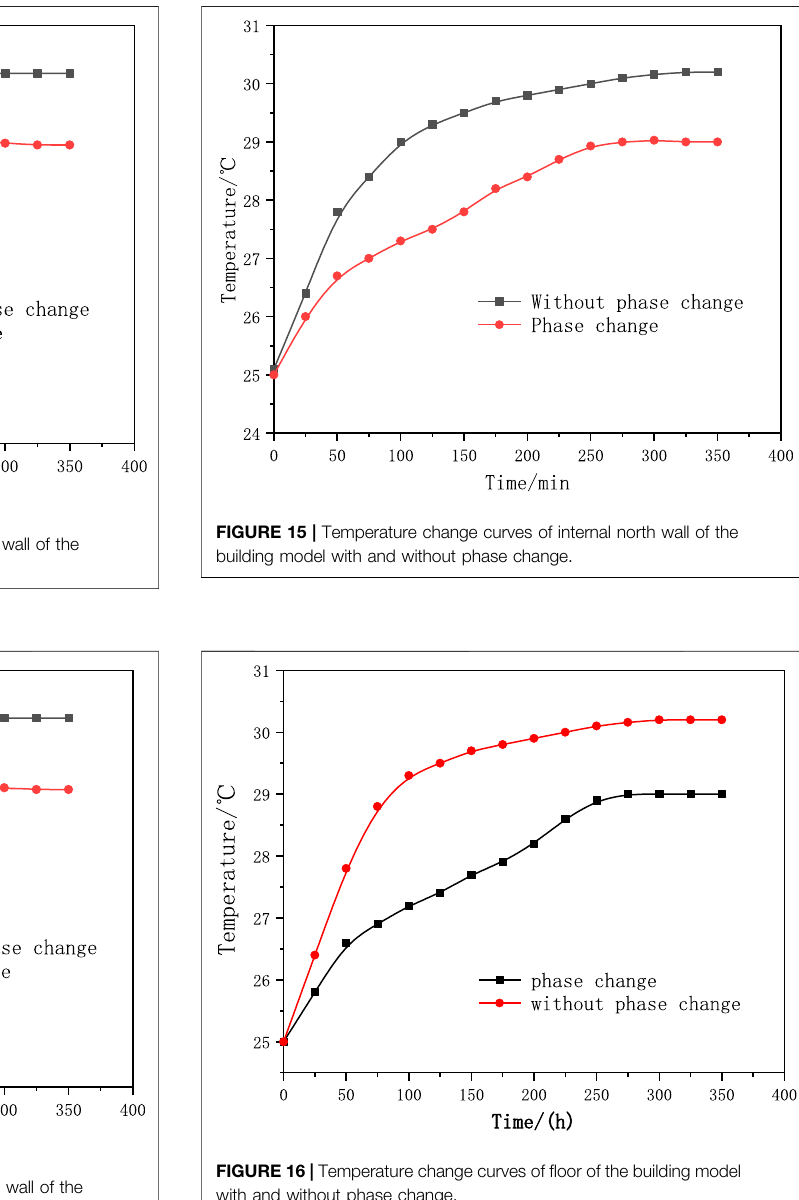
FIGURE 14 | Temperature change curves of internal west wall of the building model with and without phase change.